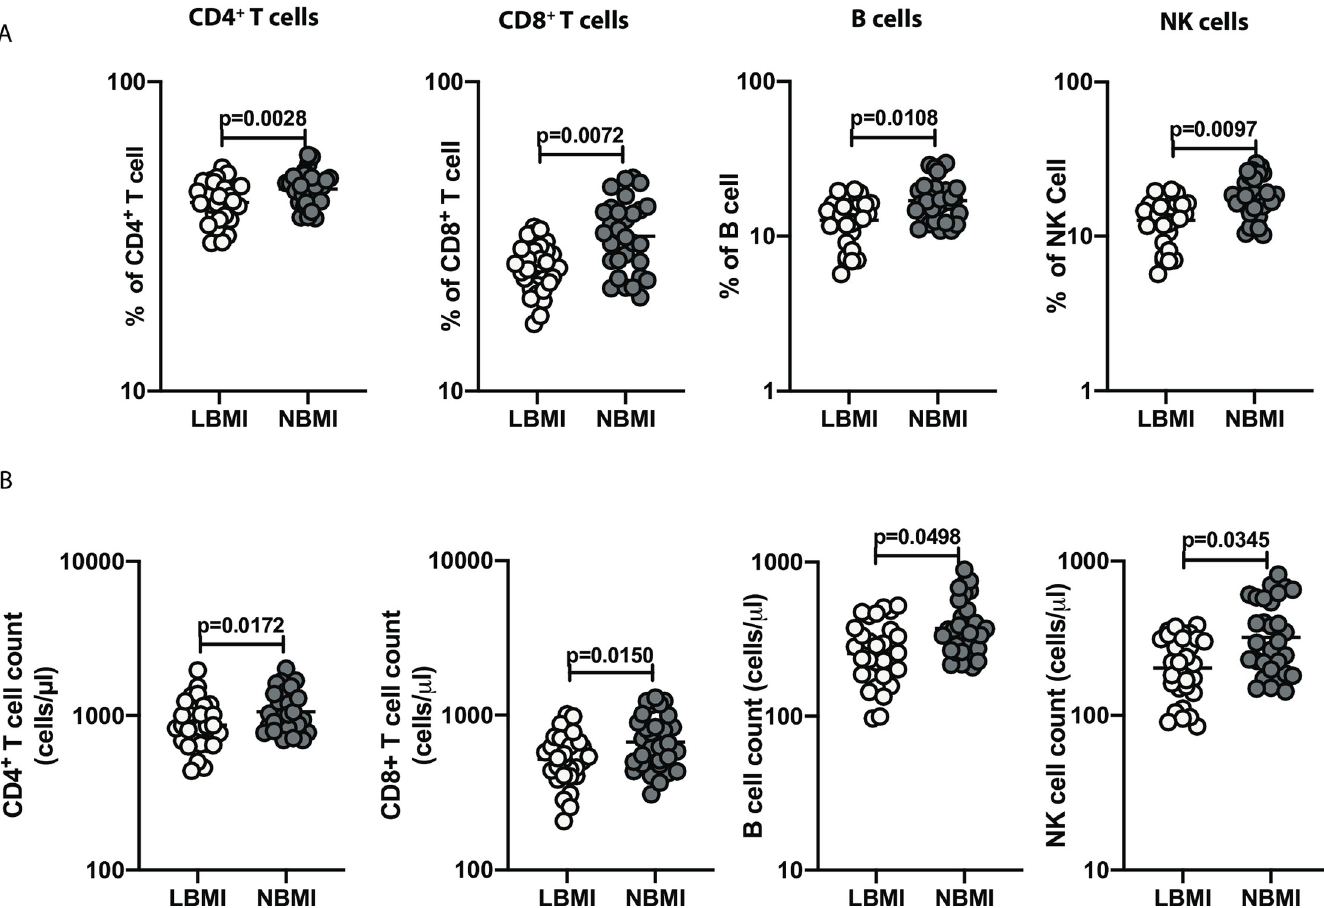
Fig 1. Low BMI is associated with diminished frequencies and absolute counts of T cells, B cells and NK cells. (A) The frequencies of CD4 + T cells, CD8 + T cells, B cells and NK cells in LTBI-LBMI [LBMI] (n = 30) or LTBI-NBMI [NBMI] (n = 30) group were measured by flow cytometry clinical software. (B) The absolute counts of CD4 + T cells, CD8 + T cells, B cells and NK cells in LTBI-LBMI [LBMI] (n = 30) or LTBI-NBMI [NBMI] (n = 30) group were measured by flow cytometry clinical software. The data are depicted as scatter plots and each circle represent a single person. Mann–Whitney U-test with Holms correction for multiple comparisons were done to calculate p